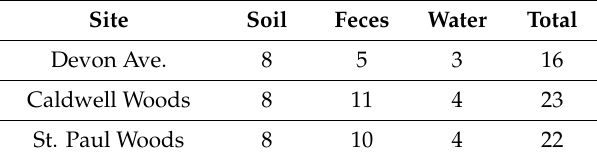
Table 2. Number of environmental samples collected at each